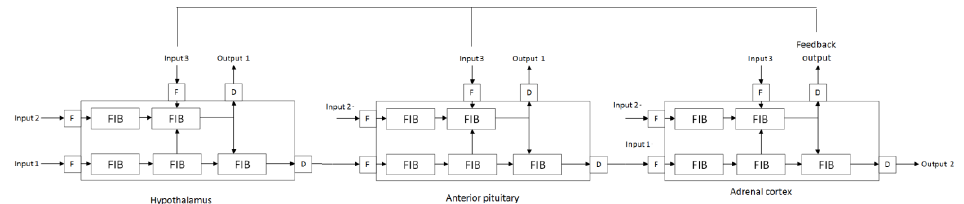
Figure 3. Computational fuzzy-based model of the HPA axis (own concept).